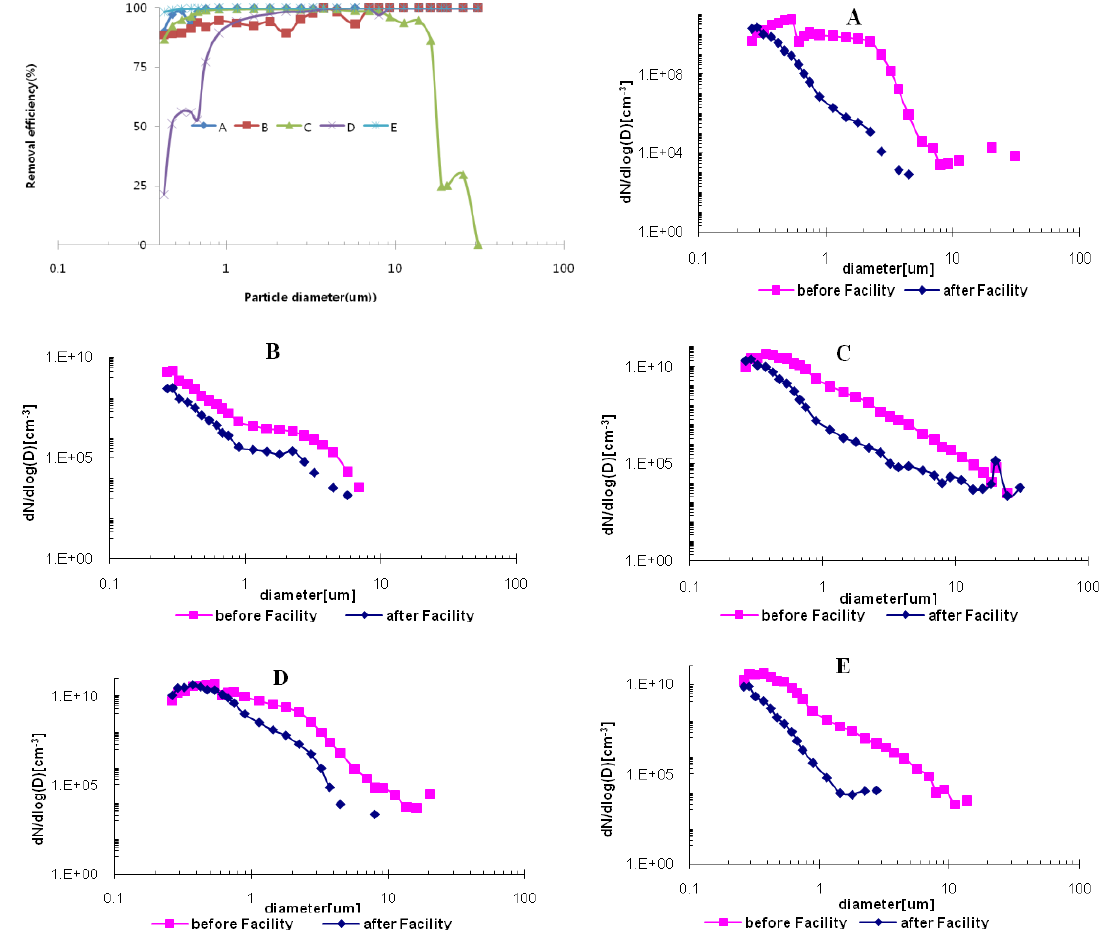
FIGURE 2. Removal efficiency of TSP as a function of particle diameter: (A) ESP, (B) ESP, (C) combination (ESP + catalyst), (D) ESP, and (E)